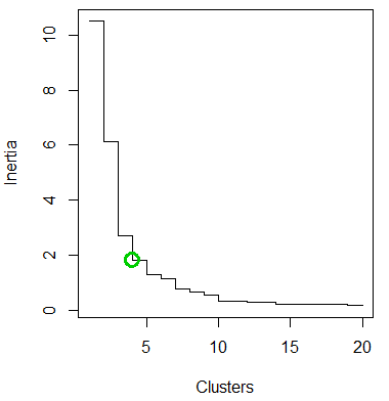
Figure 9. Inertia of AGNES-flexible on the sample. Table 2. Comparison of WSS for each hierarchical clustering.